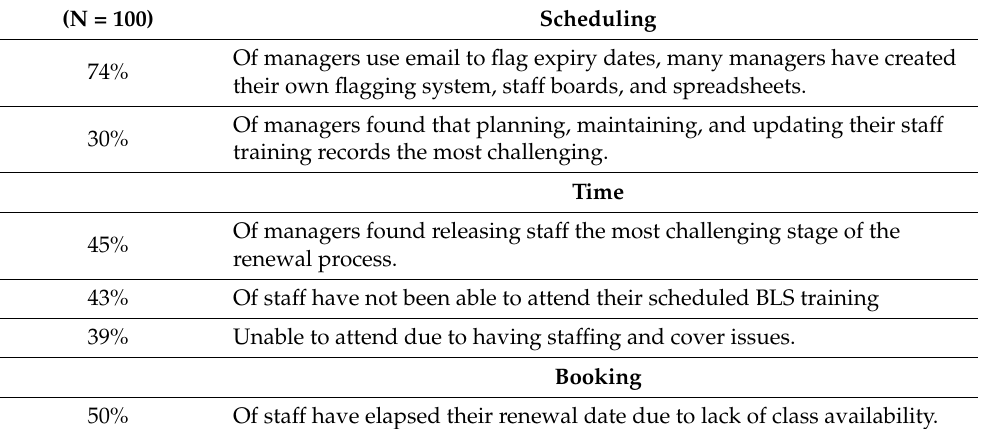
Table 3. VOC Survey